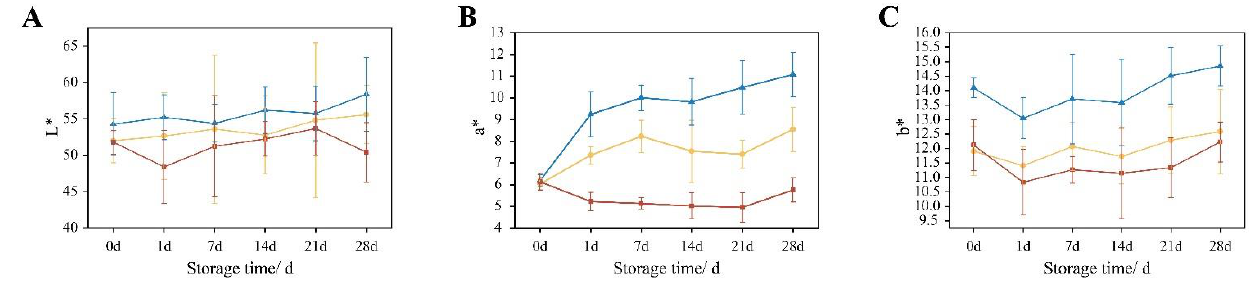
Figure 4. Change trend of color difference (a*, b*, L*) of lamb liver paste during storage period. Note: yellow represents the natural fermentation group (NF); blue represents the starter fermentation group (SF); red represents the sterilization group (ST). ( A ) represents the change of the Lightness value (L*) of the lamb liver paste with the storage time, ( B ) represents the change of the Redness value (a*) of the lamb liver paste with the storage time, and ( C ) represents the change of the Yellowness value (b*) of the lamb liver paste with the storage time.